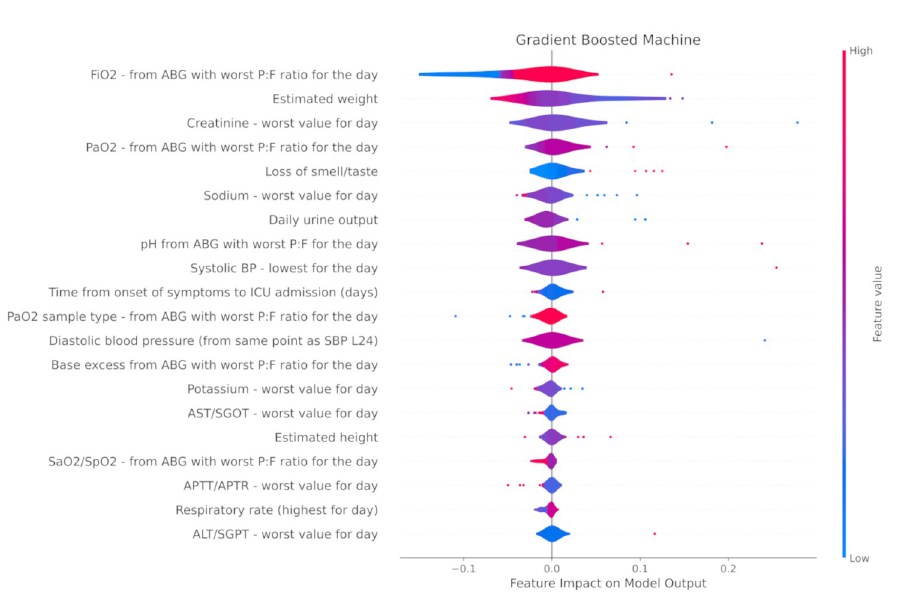
Fig 2. Summary plot showing the 20 most predictive features as defined by the GBM model for correctly classified samples. H24—Highest in first 24 hours of hospital admission, L24—Lowest in first 24 hours of hospital admission. ‘Day’ refers to the first 24 hours of ICU admission unless otherwise specified. ’Worst’ refers to the worst value as relating to the APACHE II score. P:F ratio = PaO2 divided by FiO2.